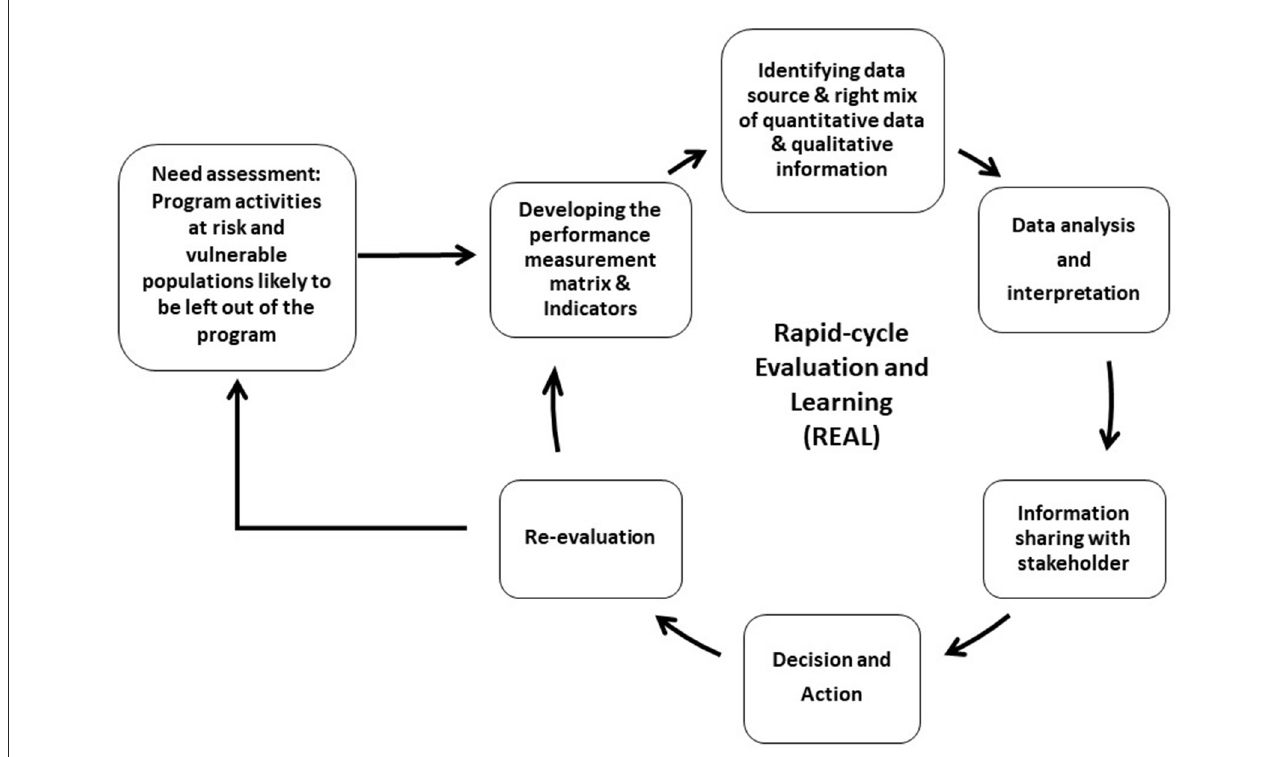
FIGURE1 Overview of the rapid-cycle evaluation and learning.